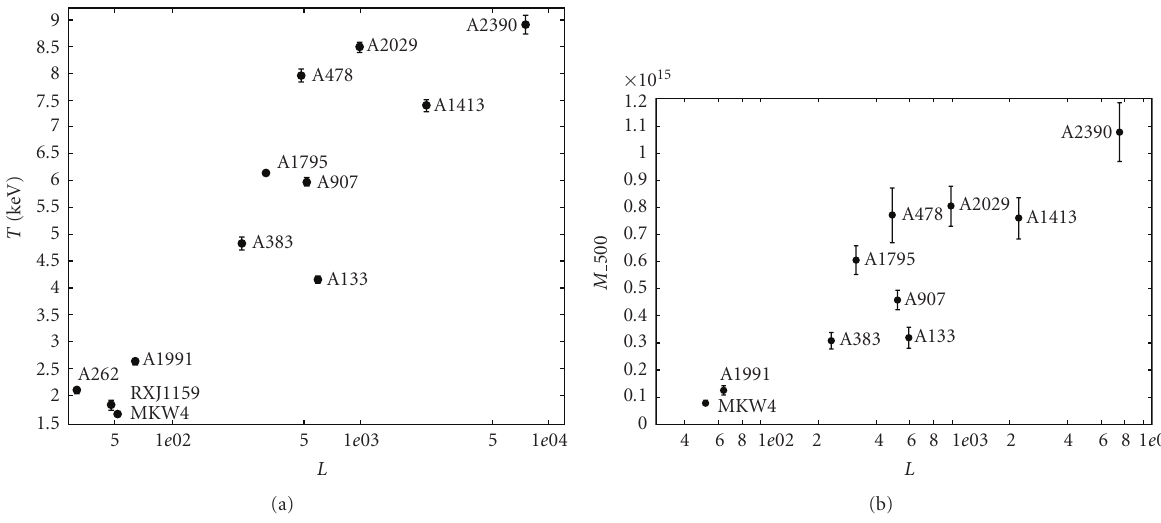
Figure 7: Single temperature fit to the total cluster spectrum (a) and total cluster mass within r 500 (given as a function of M (cid:16) ) (b) are plotted as a function of the characteristic gravitational length L . Temperature and mass values are from [129].